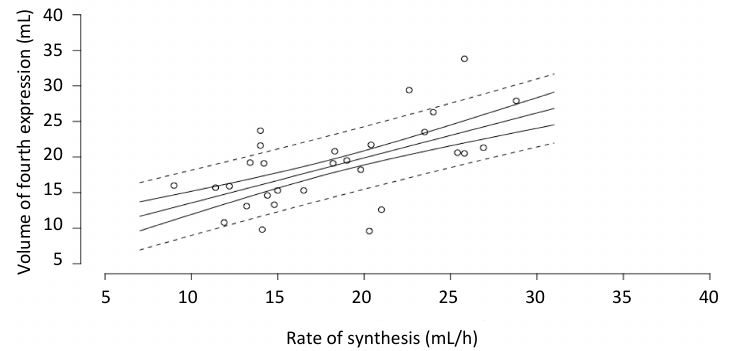
Figure 2. Relationship between the volume of milk from the fourth expression (3 h after the first expression) and the hourly rate of milk synthesis calculated from the 24-h milk profile data. Fitted model (solid line), with the confidence (solid line) and prediction intervals (dashed lines). n = 29 breasts. The fat content of the first and last milk collected at each expression and the average fat content of milk samples collected during the 24-h milk profile are presented in Figure 3. The fat content of the last milk was higher than the first milk for each expression but not statistically different at time 3 (time 0: mean difference = 34.9 g/L, SE = 8.1, p = 0.001; time 1: mean difference = 22.0 g/L, SE = 8.1, p < 0.001; time 2: mean difference = 17.8 g/L, SE = 8.1, p = 0.021; time 3: mean difference = 15.7 g/L, SE = 8.1, p = 0.092). There was no significant difference in the fat content of milk collected at the end of each of the first, second, third or fourth expressions (63.7 ± 27.6 g/L, 69.1 ± 28.2 g/L, 69.1 ± 29.4 g/L, 58.4 ± 27.0 g/L respectively). There was no significant difference between the fat content of pooled milk from the fourth expression (52.5 ± 23.5 g/L) and the average fat content of milk collected over the 24-h period (46.6 ± 8.1 g/L) (mean difference = 10.5 g/L, 95% CI: 7.2–20.1, p = 0.18).